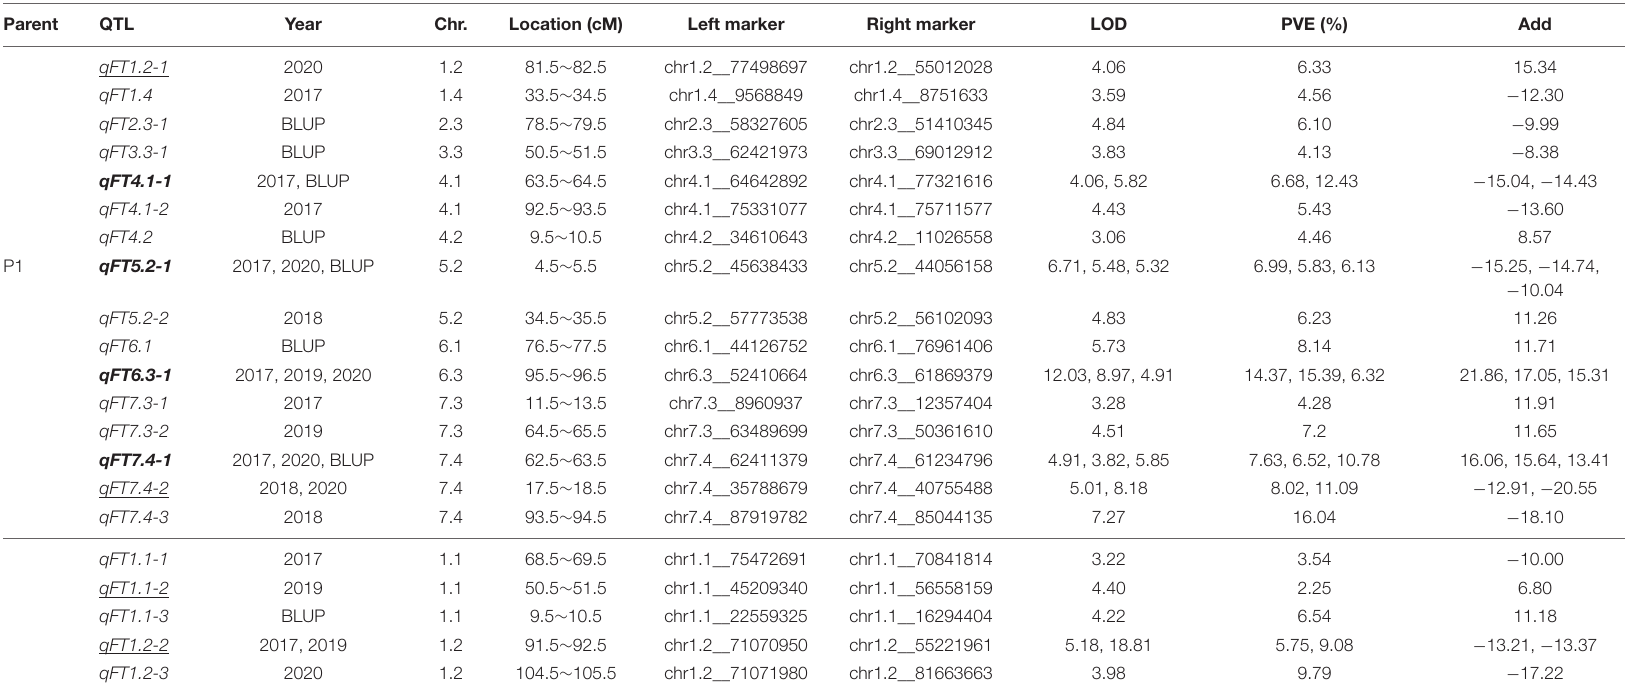
TABLE 2 | QTLs detected for least-square means (LS means) and the best linear unbiased prediction (BLUP) values of flowering time (FT) using ICIM-ADD in the F1 population.